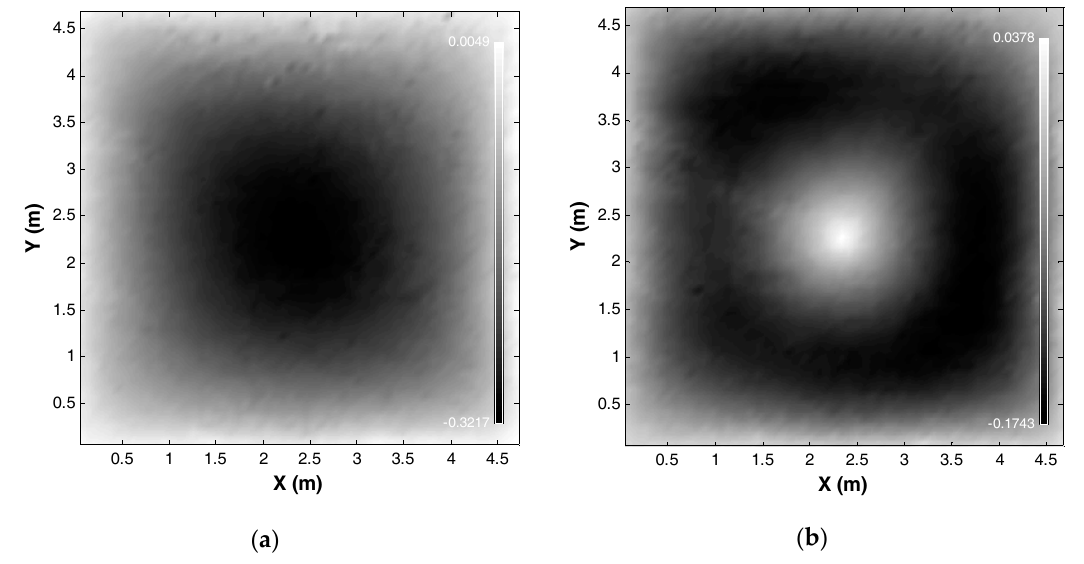
Figure 28. Elevation map: ( a ) “initial” state; and ( b ) “deformed” state.